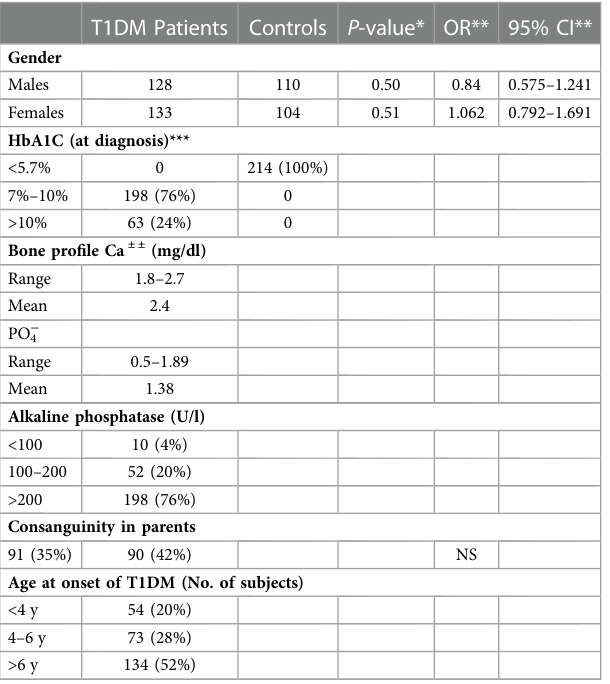
TABLE 1 Characteristics of Kuwaiti T1DM patients ( n =261) and controls ( n =214) included in the study.